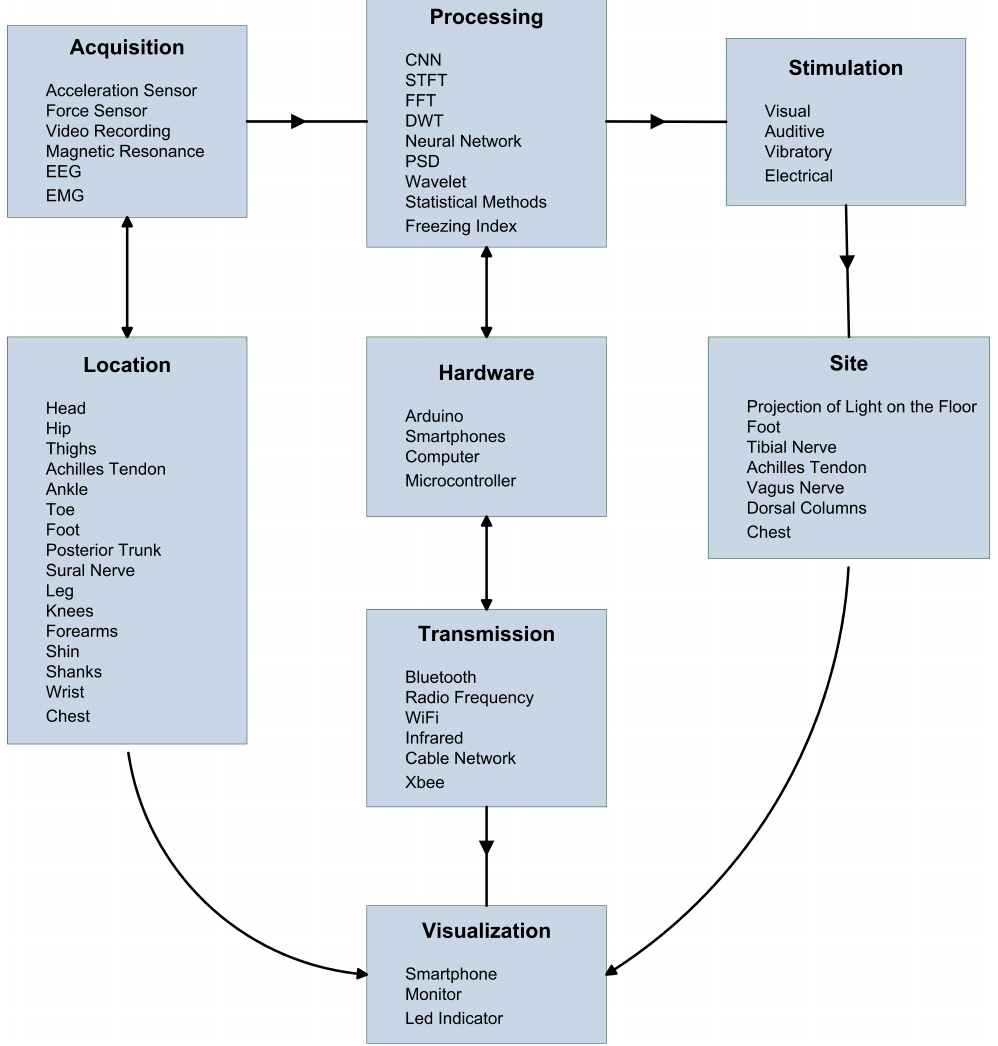
Figure 2. Analysis of non-invasive techniques most used in patients with FoG: acquisition systems, devices, transmission, visualization, data processing, and stimulation. ElectroEncephaloGraphy (EEG), ElectroMyoGraphy (EMG), Convolutional Neural Network (CNN), Short-Time Fourier Trans- form (STFT), Fast Fourier Transform (FFT), Discrete Wavelet Transform (DTW), and Power Spectral Density